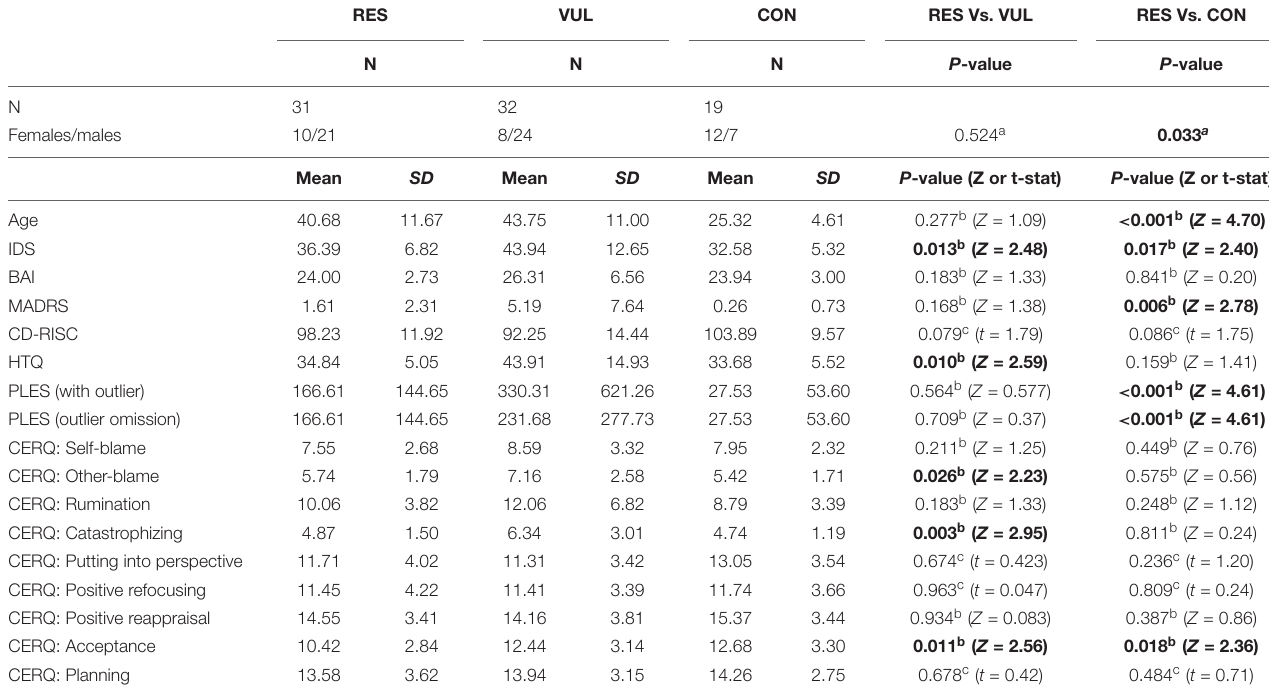
TABLE 1 | Characteristics of the study population. RES VUL CON RES Vs. VUL RES Vs. CON N N N P -value P